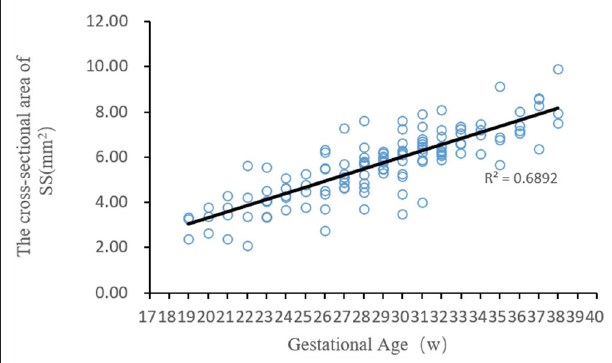
FIGURE 3 | The fitting curve between the cross-sectional area of the fetal straight sinus at different gestational ages and the gestational